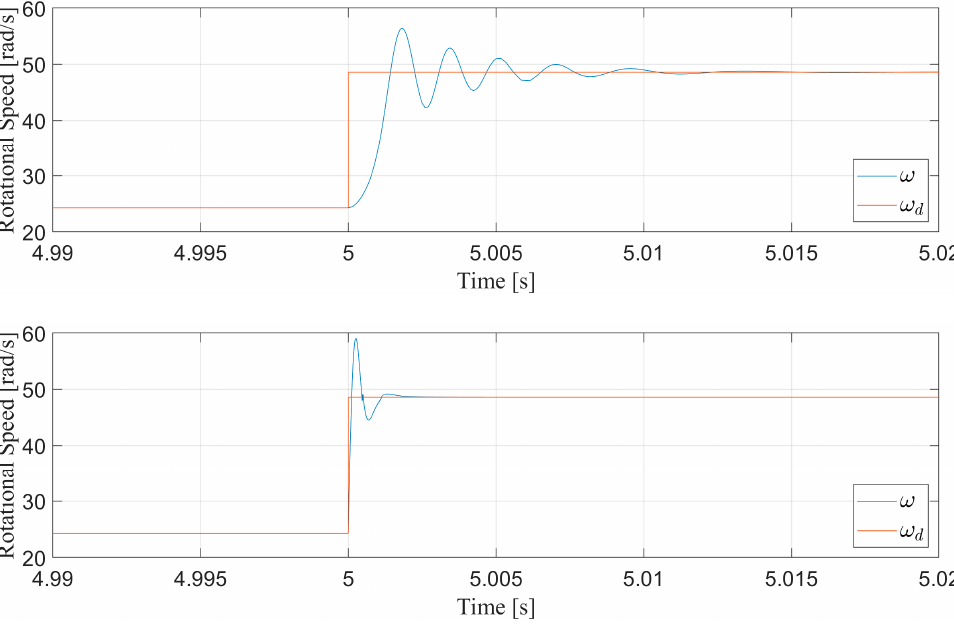
Figure 5. Response of a vector controller (above) and nonlinear controller (below) to a step in wind speed.